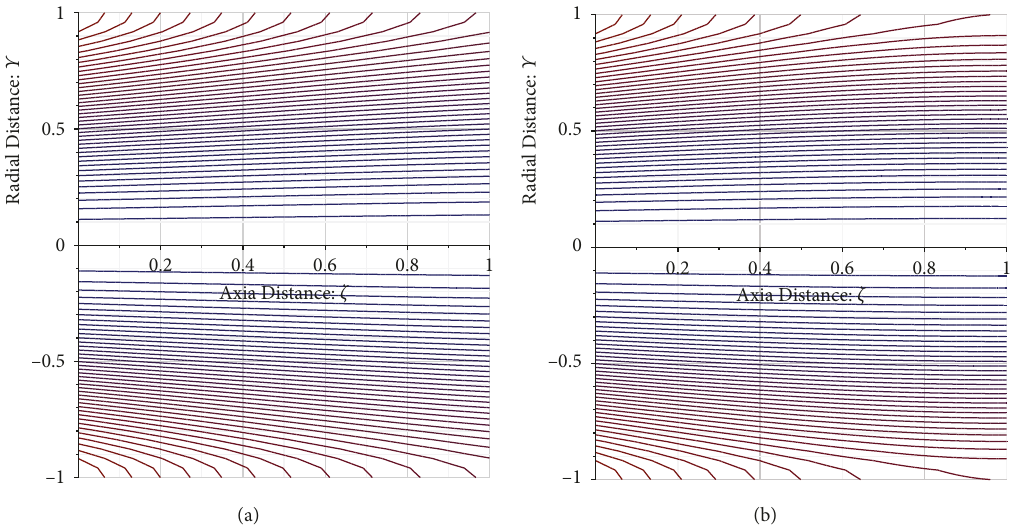
Figure 6: Stream lines for W � 0 . 5 × 10 − 5 and different values of S . (a) S � − 0 . 3 × 10 − 5 . (b) S � − 0 . 5 × 10 − 5 . 0